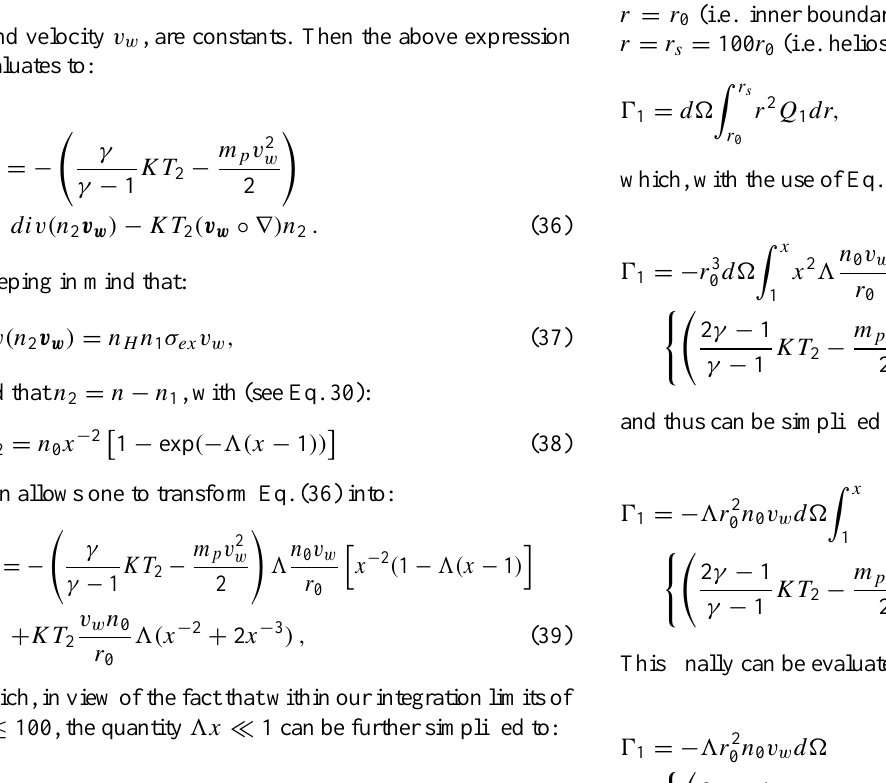
Fig. 4. Plotted is the polytropic index γ 1 versus the logarithm of the solar distance r at 3 = 1 · 10 − 3 and T 1 , 0 = 5 · 10 4 K for different values of 1α = α 1 − α 2 , i.e. for 1: 1α = 50 , 2: 1α = 30 , 3: 1α = 10 .